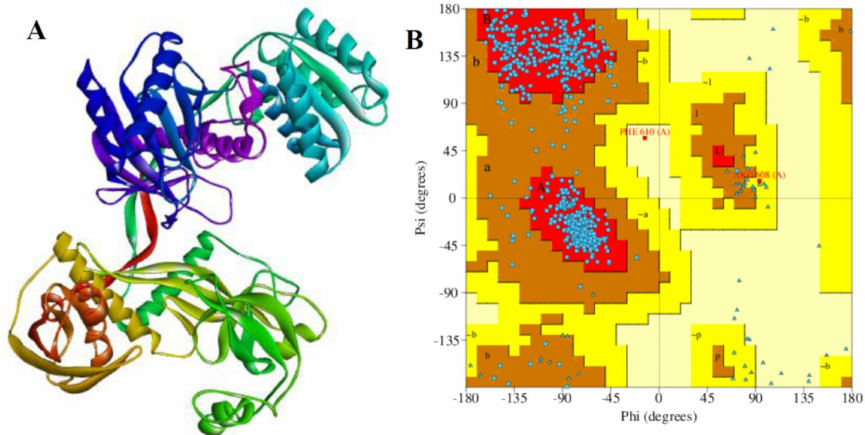
Figure 6. The structural details of the receptor. ( A ) Prepared chain A (Maestro, Discovery studio) and ( B ) its Ramachandran plot (PDBSum, PROCHECK). The quality of the prepared chain A was estimated by PDBSum server. The residues in most favored regions (A, B, L), the residues in additional allowed regions (a, b, l, p) and residues in generously allowed regions (~a, ~b ~l, ~p). The structural details of chain A (ID: 3F37: A) consist of 6 sheets, 9 gamma turns, 12 beta hairpins, 14 beta bulges, 33 strands, and 55 beta